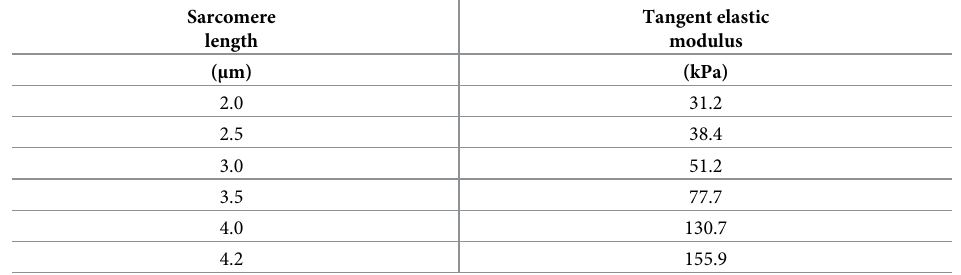
Table 2. Average tangent longitudinal modulus of bundles obtained from Eq (9), fitted to experimental data, at different values of bundle sarcomere